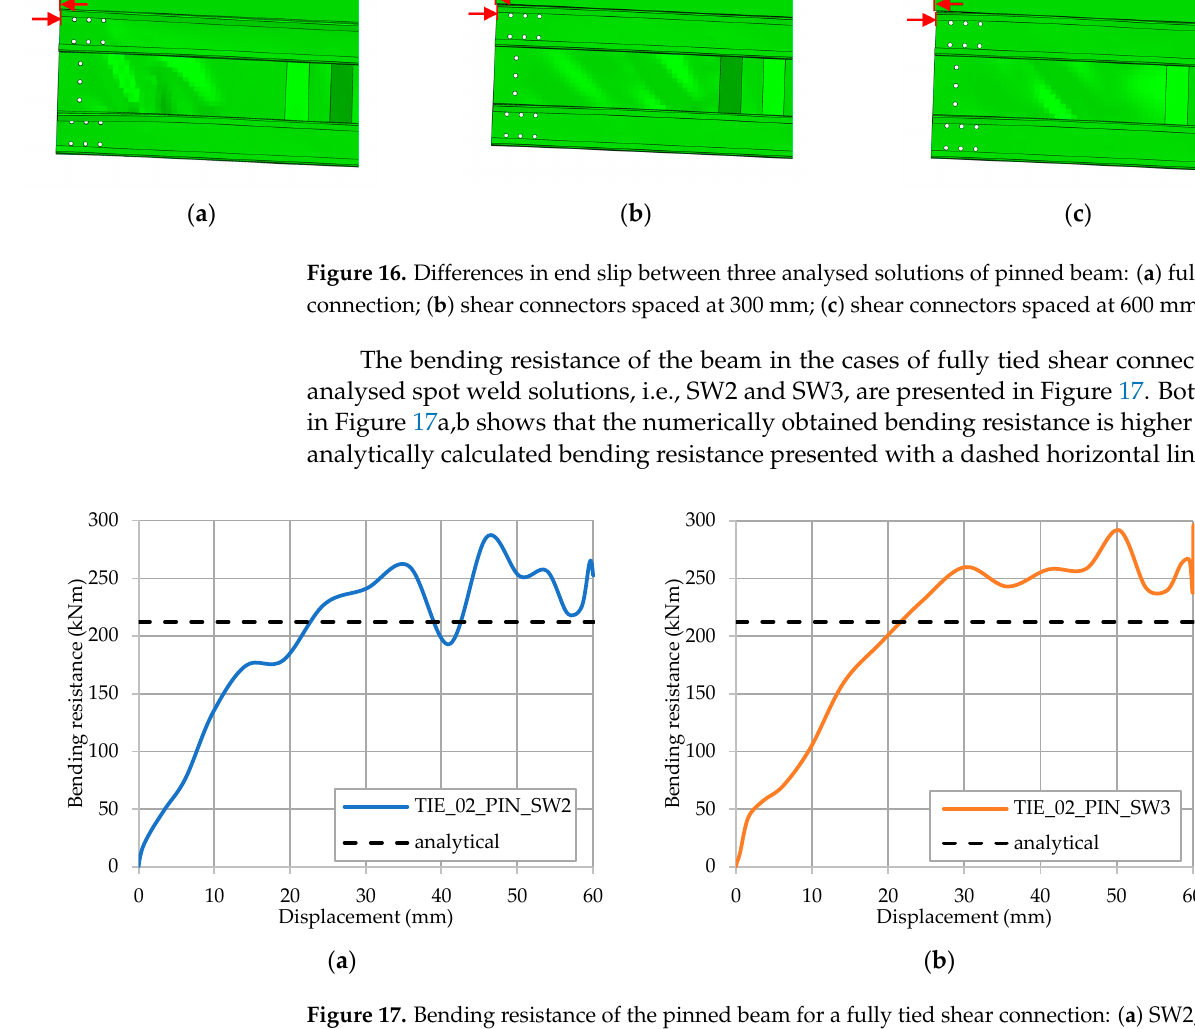
Figure 18. Bending resistance of the pinned beam for shear connectors spaced at 300 mm: ( a ) SW2; ( b ) SW3. In the case when shear connectors are spaced at 600 mm, similar results are obtained as the ones when the spacing of 300 mm is applied. The obtained results are presented with curves in Figure 19. From the curves in Figures 17–19, it can be observed that the solutions with SW2 and SW3 spot weld configurations are in good correlation. The number of SW does not govern the bending capacity of pinned beam solutions to a great extent.